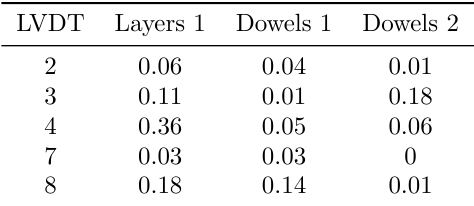
Table 1. Reading of the